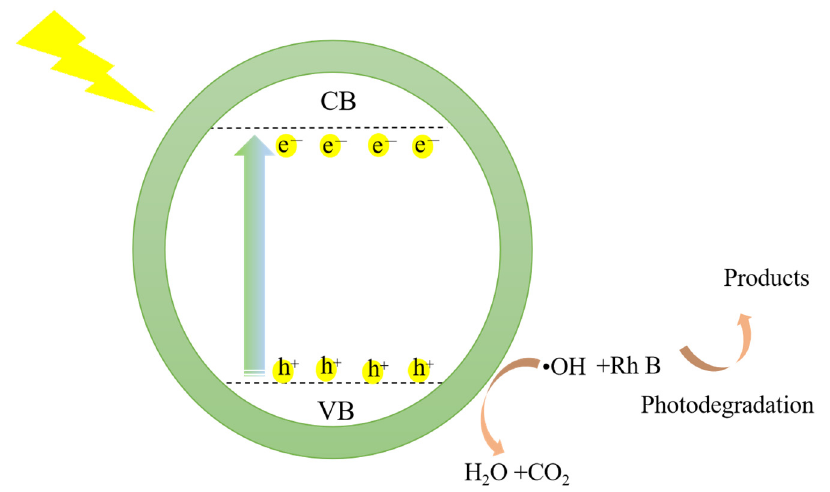
Figure 5. The degradation mechanism of Rh B.